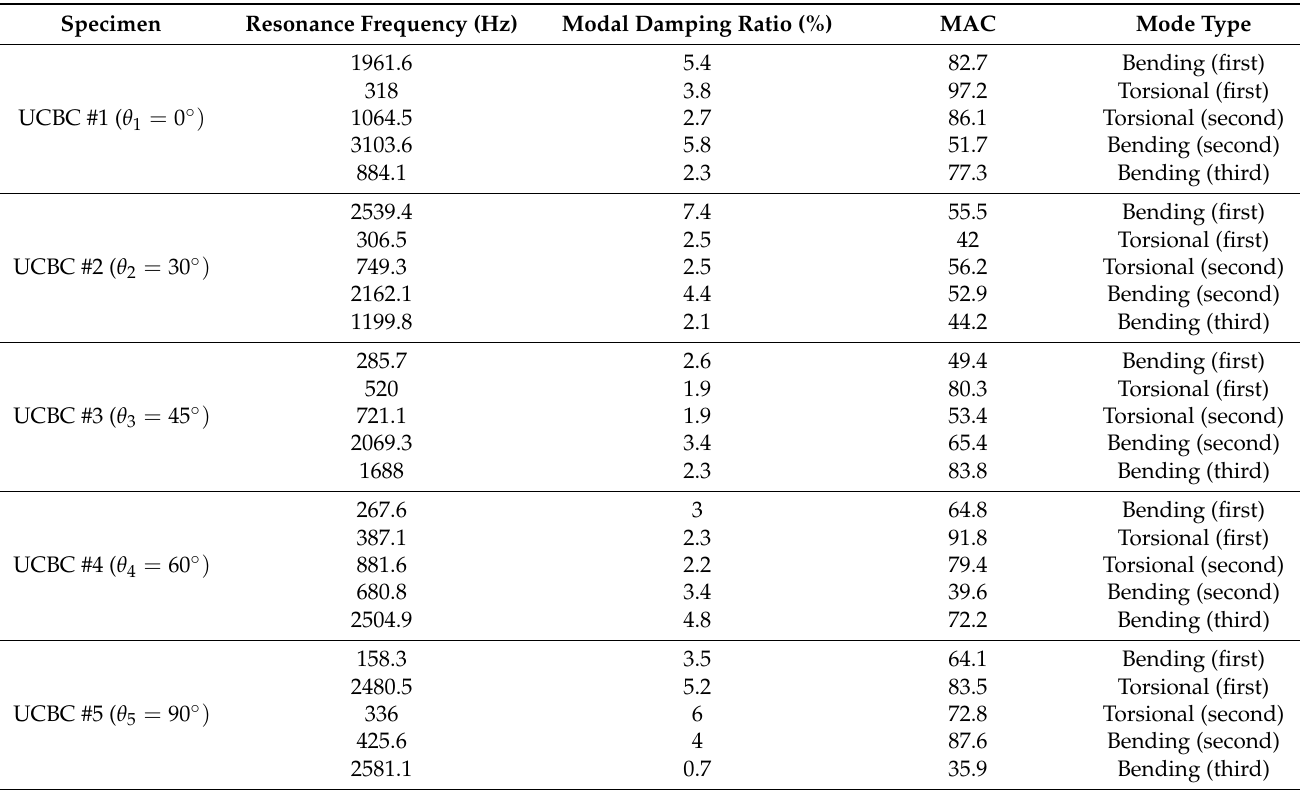
Table 2. Modal parameters and MAC values of UCBC